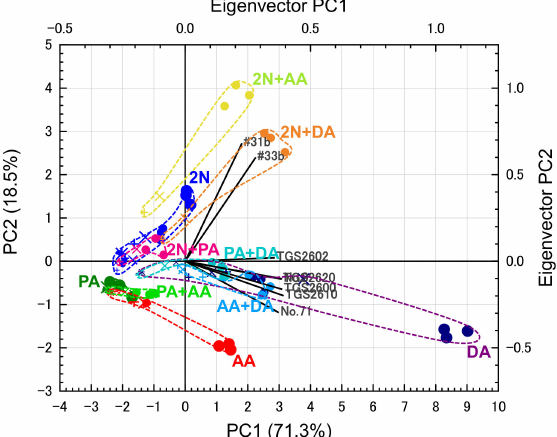
Figure 5. PCA scores and eigenvectors from eight sensors for one and two target gases (see Table 3 for types of